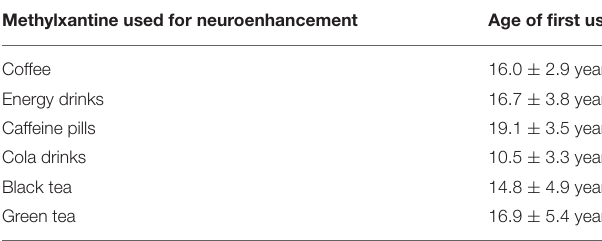
TABLE 5 | Age of first use of methylxanthines for neuroenhancement. Methylxantine used for